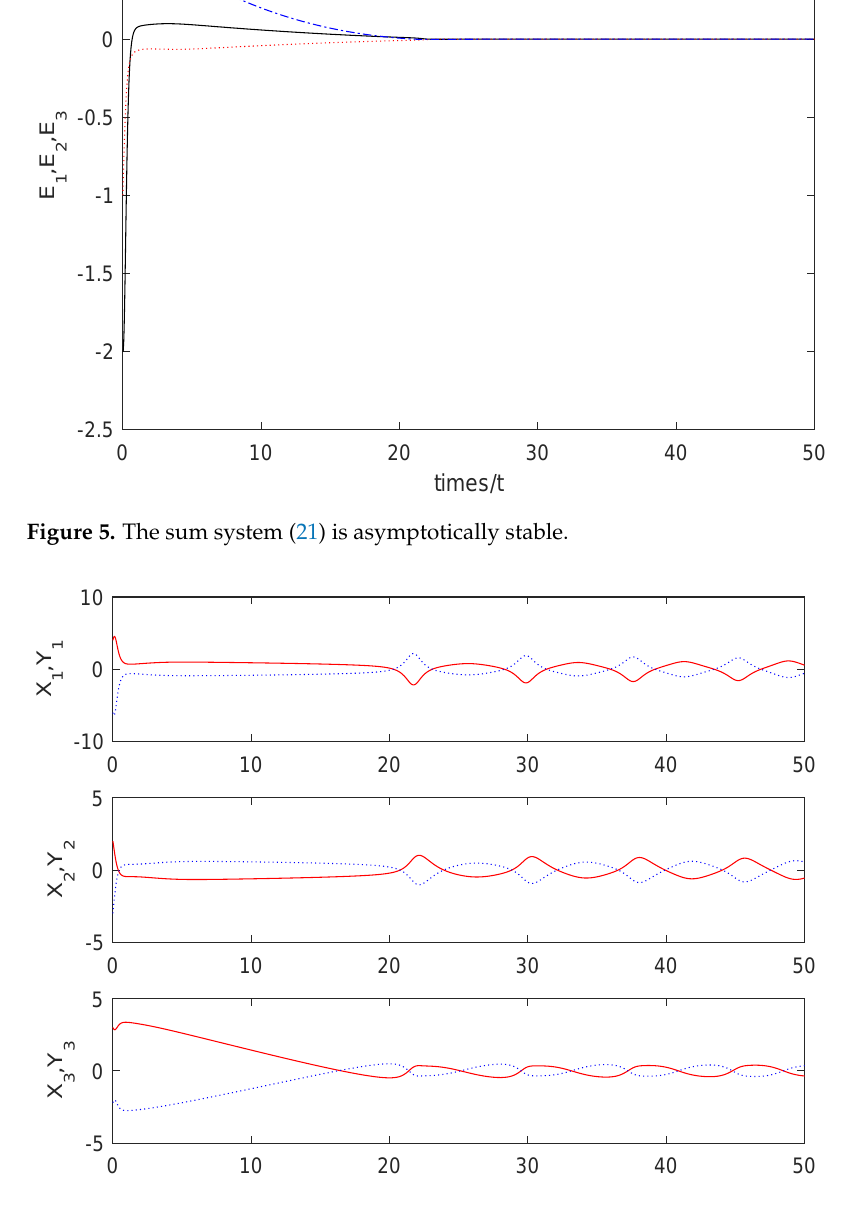
Figure 6. The states of the master subsystem and the slave